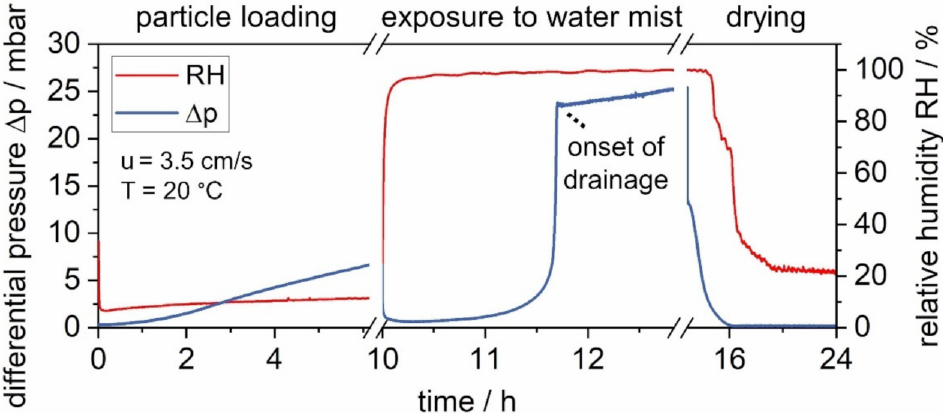
Figure 6. Evolution of differential pressure and RH evolution during particle loading with soluble salt, exposure to water mist, and drying.